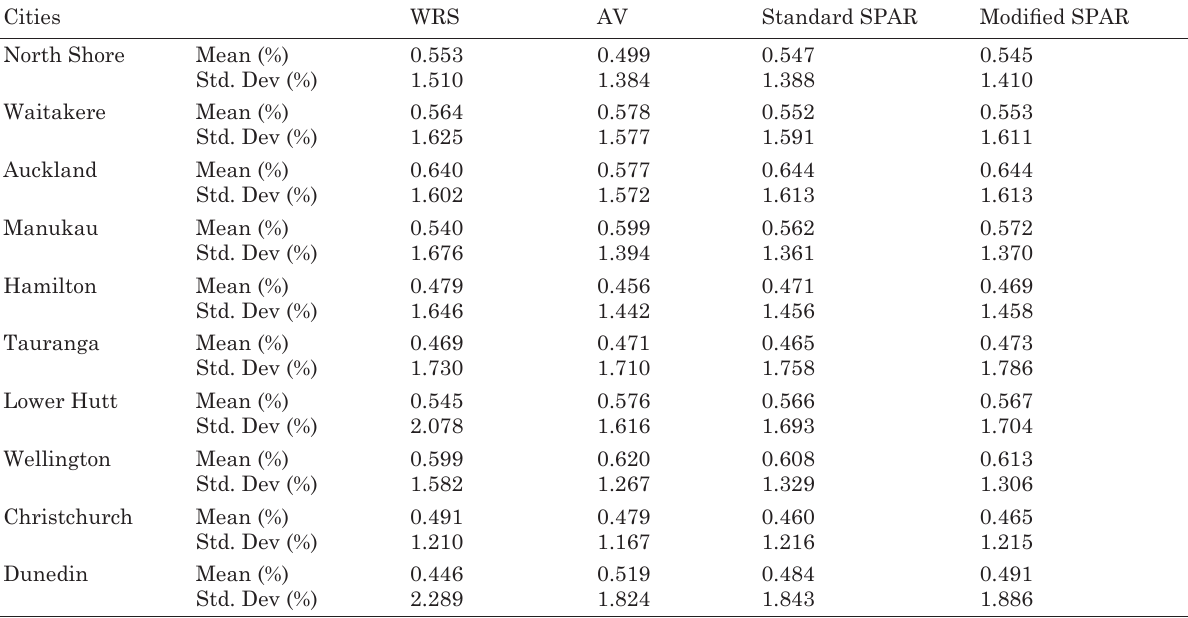
Table 6. Monthly changes in estimated house price indices,